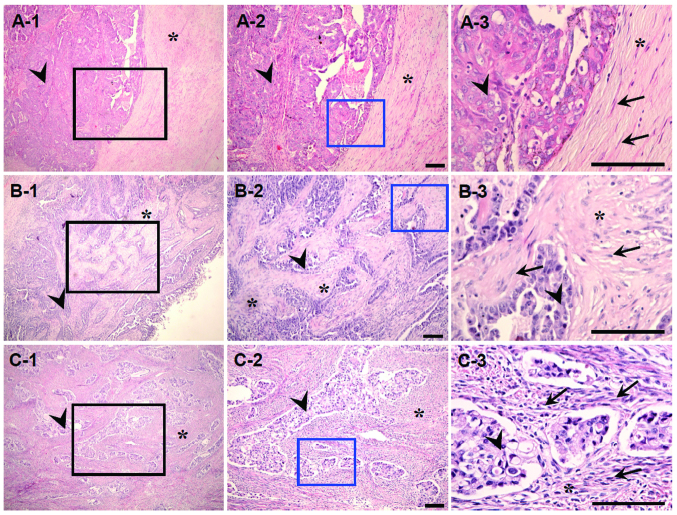
Ovarian cancer without modeling (A1–3) and with indistinct (B1–3) and distinct (C1–3) modeling (H&E staining). A-2, B-2 and C-2 present fragments indicated by black squares; A-3, B-3, C-3 present fragments indicated by blue squares. Asterisks indicate stroma, arrow heads indicate tumor nests, arrows indicate fibroblasts. Scale bars, 100 μm.